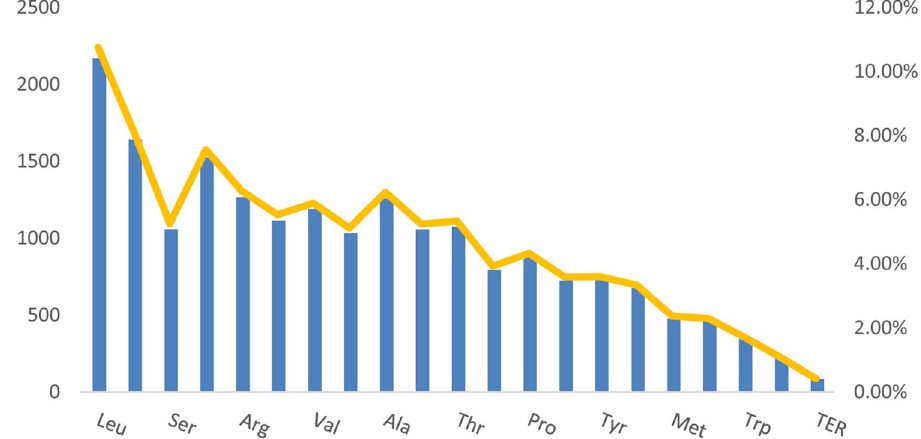
Figure 4. Amino acid frequencies in C. hirtinoda cp genome protein coding sequences. The column diagrams indicate the number of amino acid codes, and the broken line indicates the proportion of amino acid codes.